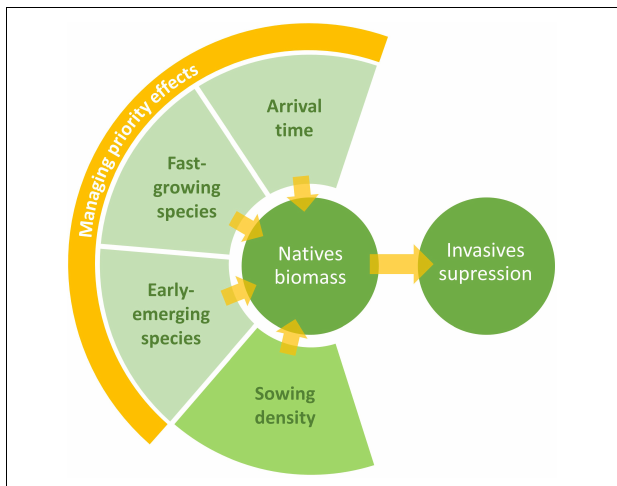
FIGURE 3 | Management recommendations for restoration based on our experiment results. We advise to enhance priority effects when designing seed-mixtures, for instance by selecting early emerging and/or fast-growing native species. Increased native species biomass could also be accomplished by assuring that native species dominate the early community. If possible, the use of high sowing density of natives is also